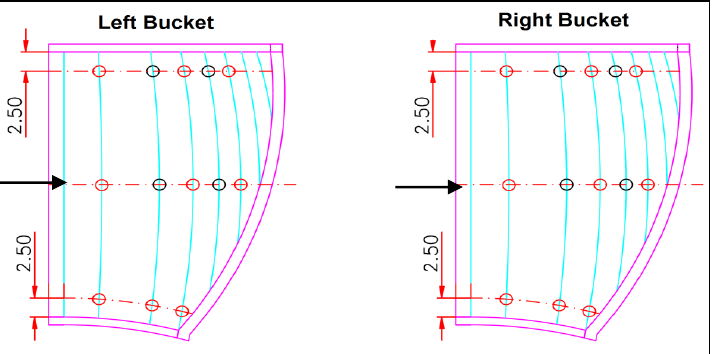
Figure 3. Position of pizeometers on the left and right scaled models of the buckets (plan view)